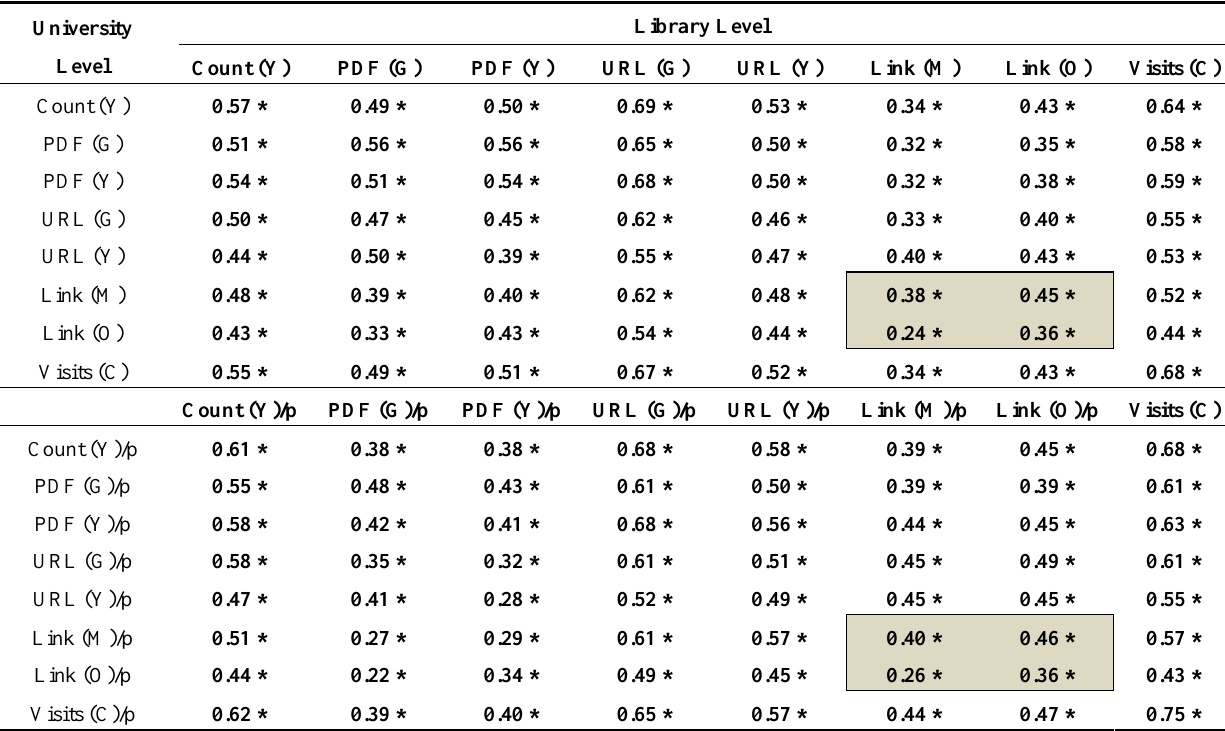
Table 5. Correlation among university web data.